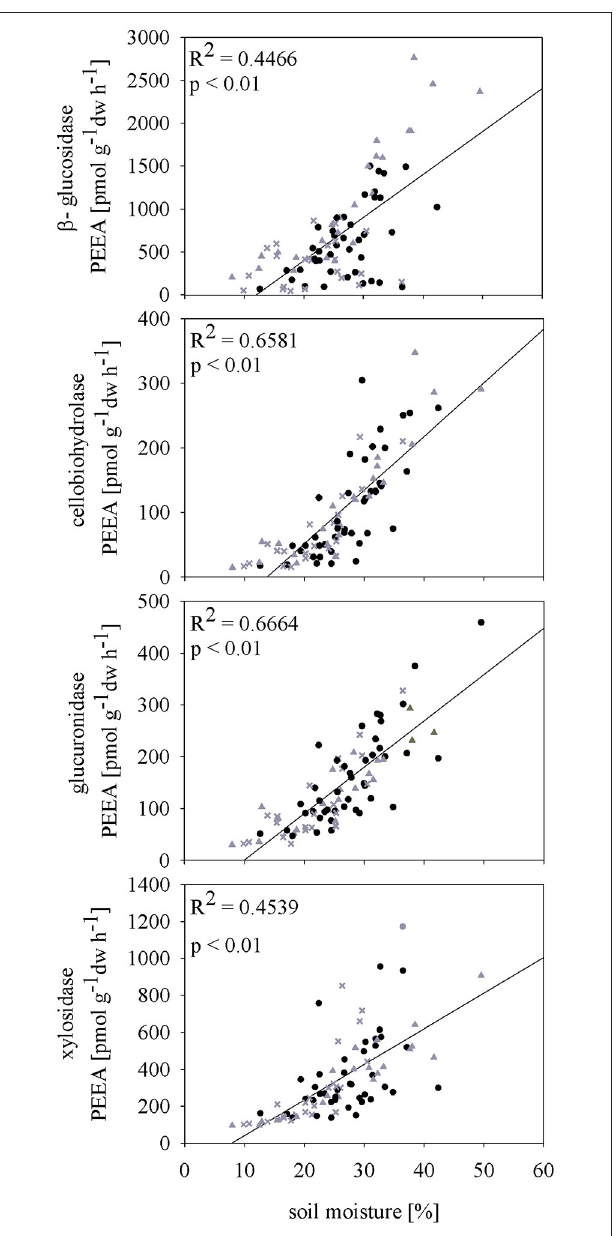
FIGURE 3 | Pearson correlation of soil moisture [vol %] and potential extracellular enzyme activities (PEEA) [pmol MUF g − 1 h − 1 ] of 2010 under different precipitation variabilities (control (C) black dots, spring drought (D1) gray crosses and summer drought (D2) gray